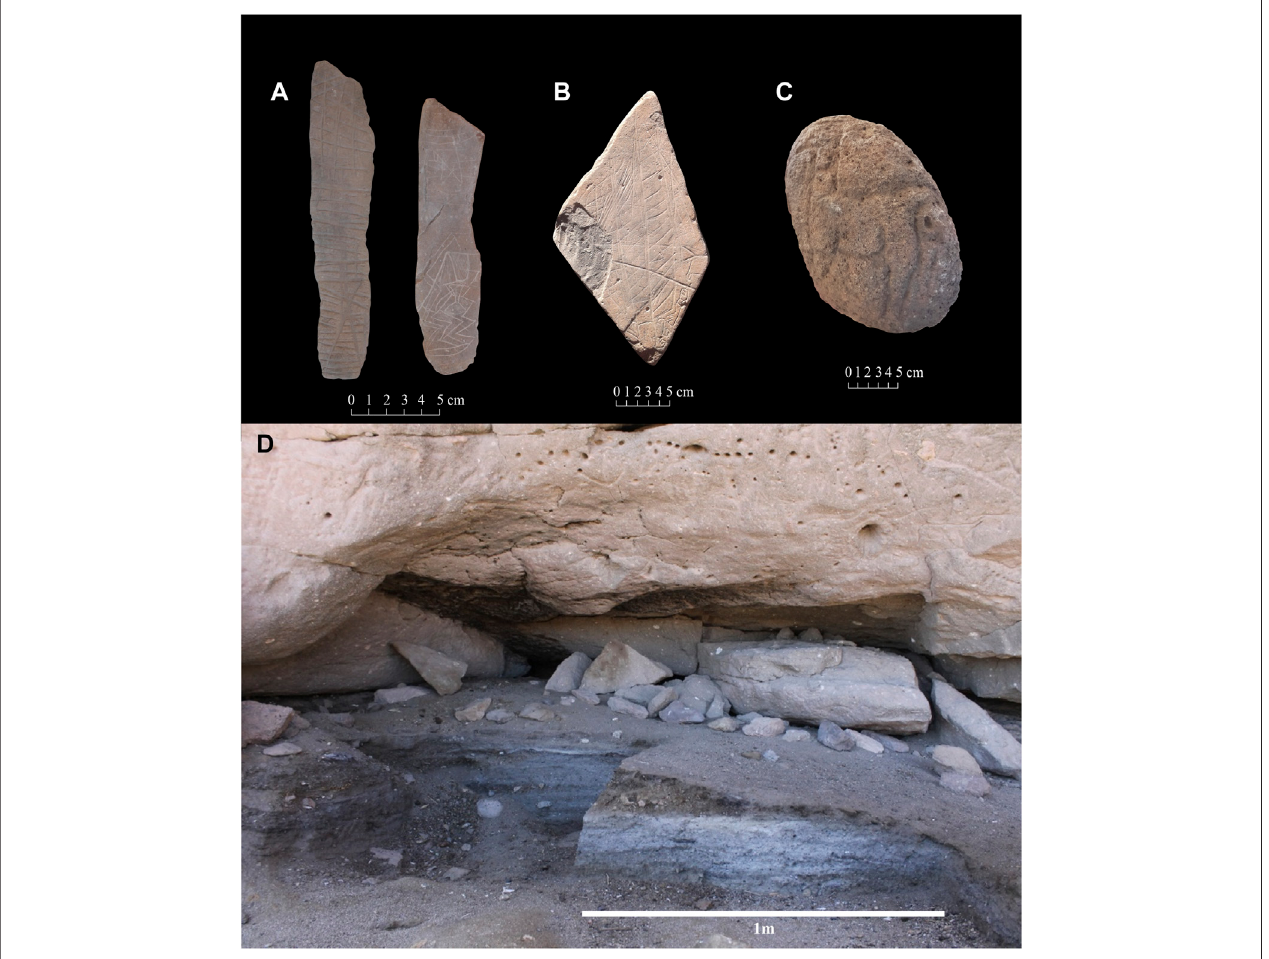
FIGURE14| Engraved lithicsonvolcanicrocks: (A) engravedbladeswithgeometricmotifsondevitri fi edcineritictuff(TulánCerros-2site); (B) engravedplaquettes fromTulánCerrosindevitri fi edcineriticbrowntuff(collectionofGustavoLePaige); (C) volcanictuffwithengravedcamelidmotifrecoveredfromtheinitialoccupation fl oor of the Puripica-1 site (Núñez 1983); (D) Late Early Archaic occupation in ash stratigraphic layer (light gray): site Tulán-109 (Núñez et al., 2005).